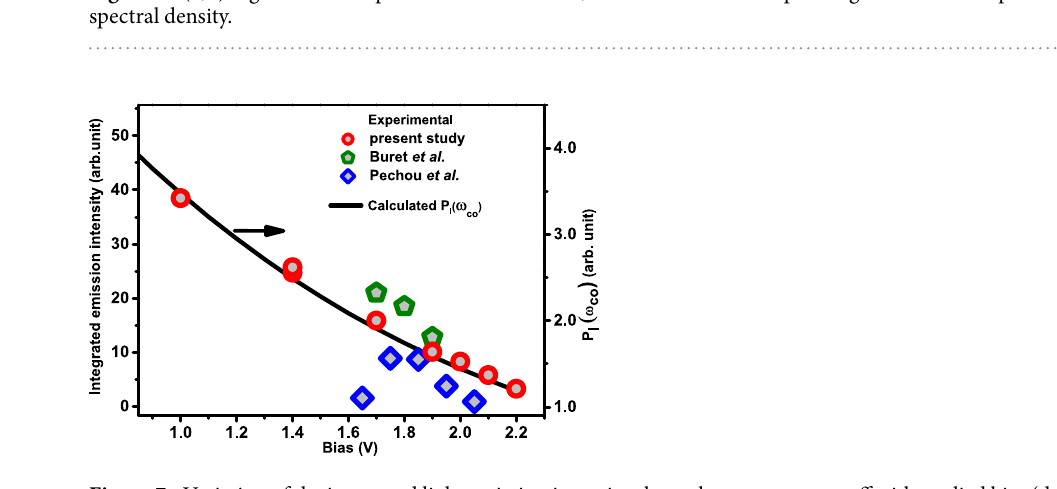
Figure 7. Variation of the integrated light emission intensity above the quantum cut-off with applied bias (data from refs 14, 54 is also included). Solid line shows the variation of residual P I ( ω co ) with